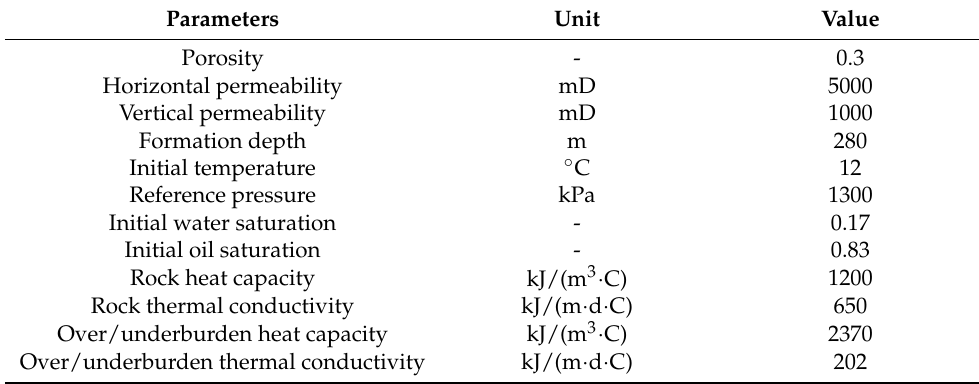
Table 1. Reservoir properties in the simulation model.